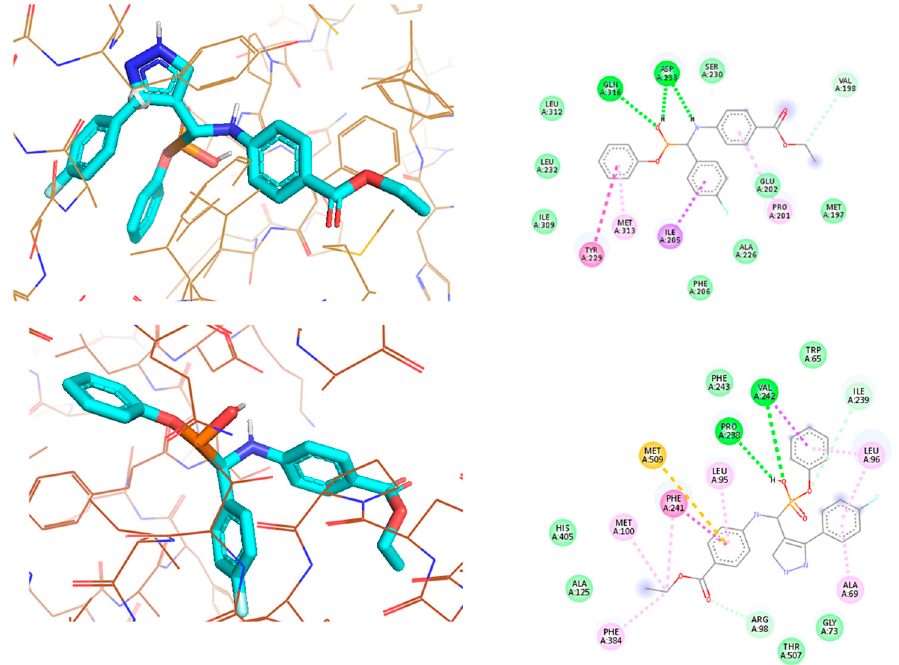
Figure 4. Interactions between compounds 5a , 5f and lanosterol-14 α -demethylase. The results obtained by molecular docking show the importance of the substituents mentioned in the in vitro results section and suggest that the mechanism of action of the compounds is by allosteric inhibition, since there is no interaction of the molecules with the active site of the molecule. This could be associated with a reduction in the toxicity of the molecules 5a and 5f since the mechanism of action is not related to the covalent coordination of the heme group of lanosterol-14 α -demethylase, as is the case for many antifungal azoles [41]. These data is supported by cytotoxic tests carried out in the previous section (Section 3.3). One of the major issues in the treatment of fungal diseases is the limited availability of compounds that possess good in vitro and in vivo antifungal activity with low cytotoxicity; these results show that compounds 5a and 5f are good candidates for further investigation of their therapeutic efficacy in